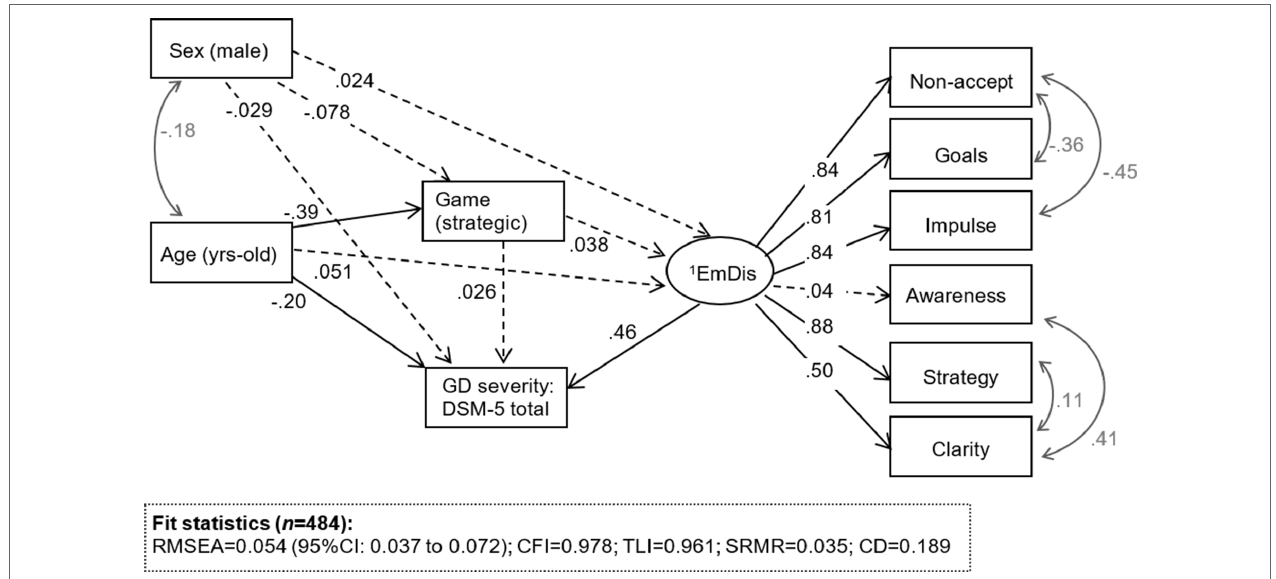
FIGURE 1 | Sem model for the whole sample, standardized coefficients. Note. 1 EmDis: emotional dysregulation (latent variable defined with the DERS first order scales). Continous line: significant coefficient (.05 level). Dash-line: non-significant coefficient. Grey: covariance